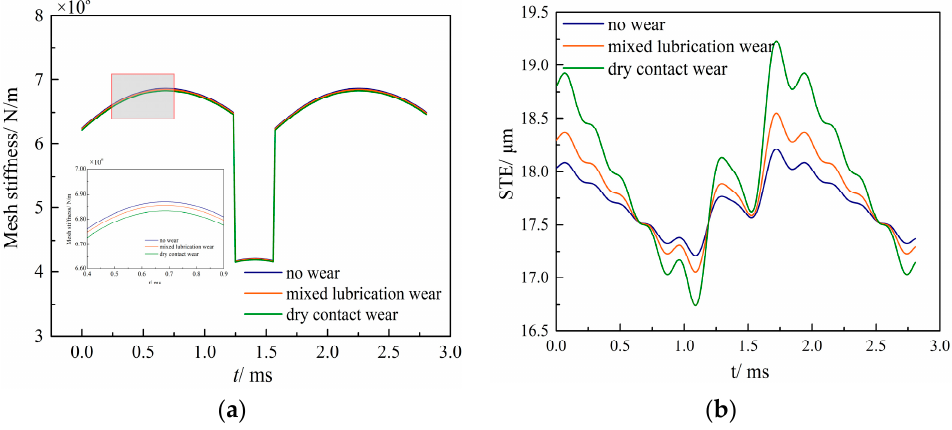
Figure 8. Gear mesh stiffness and static transmission error. ( a ) TVMS. ( b ) STE.